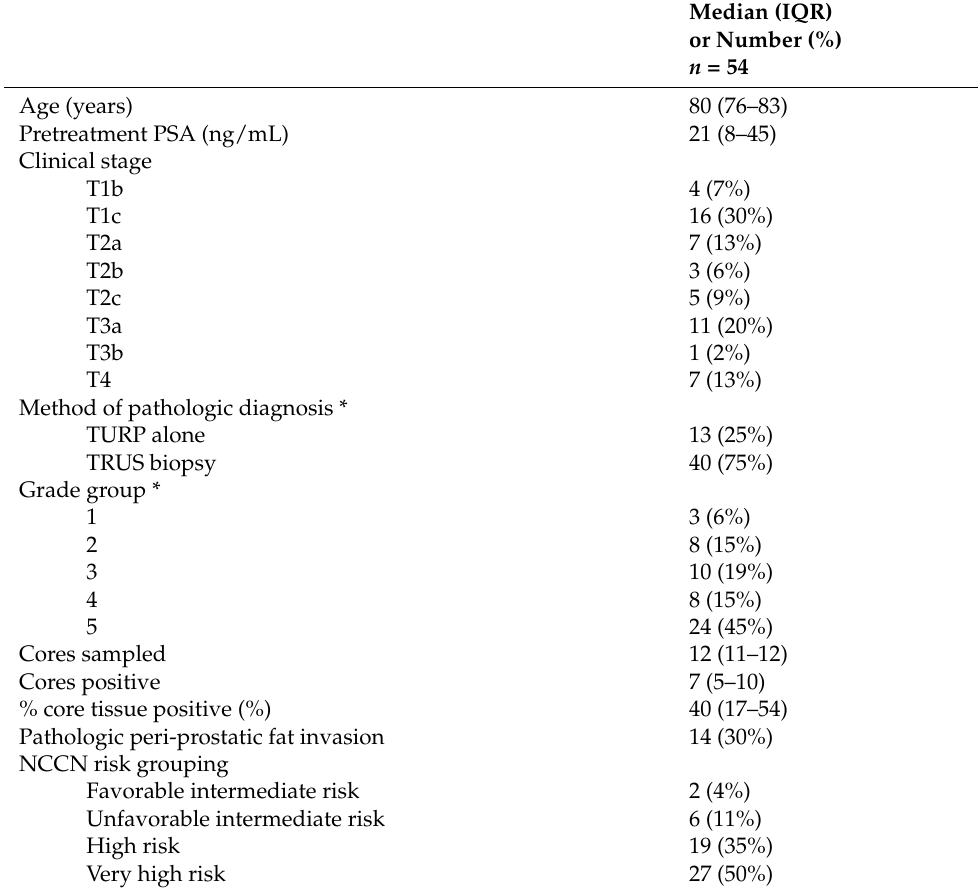
Table 1. Baseline demographic and pathologic characteristics for 54 elderly patients with prostate cancer receiving dose-reduced, palliative external beam radiotherapy to the prostate.